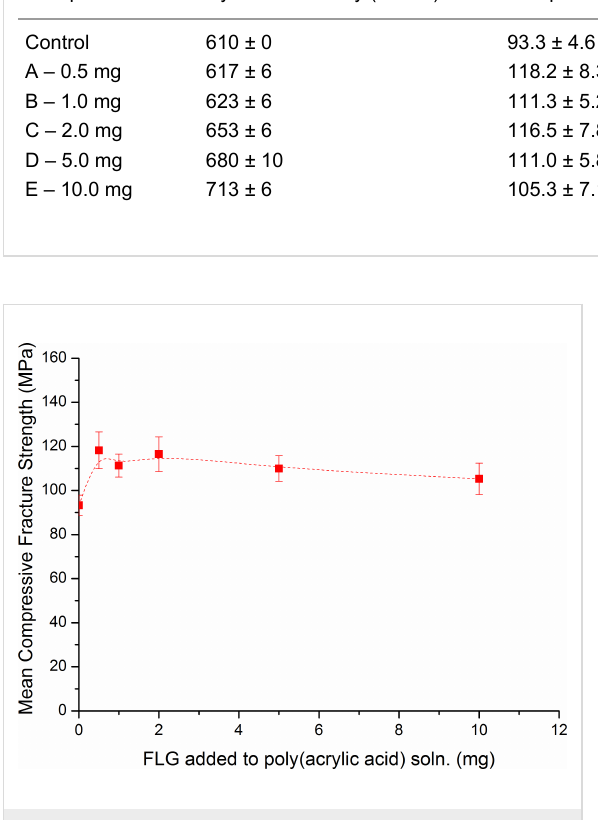
Figure 5: Change in mean compressive modulus with increasing graphene